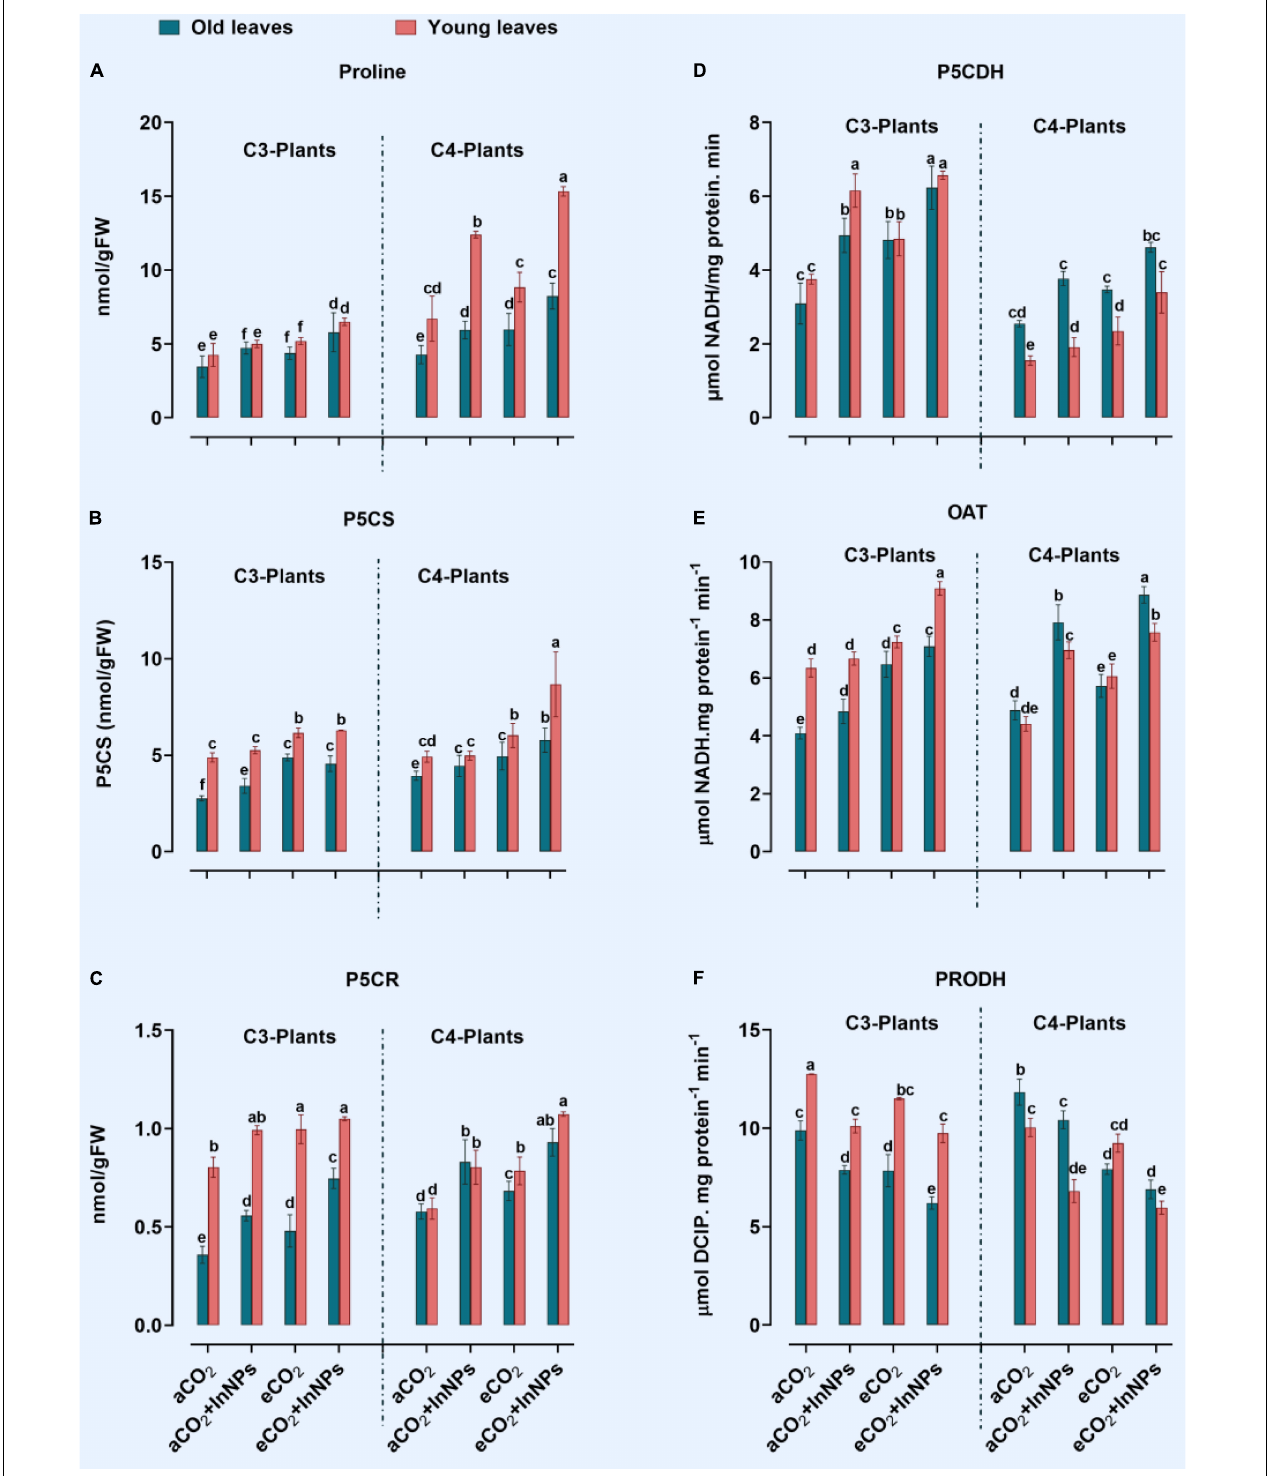
FIGURE 4 | (A–F) Effect of the co-application of future climate CO 2 and In 2 O 3 -NPs upon proline metabolism in both old and young leaves of C3 and C4 plants. Four biological replicates are used to measure each value. The bars on the columns represent error bars (SE). One way ANOVA test (P < 0.05; n = 4) was applied to show the significant difference between groups. Different letters showed the significant difference between